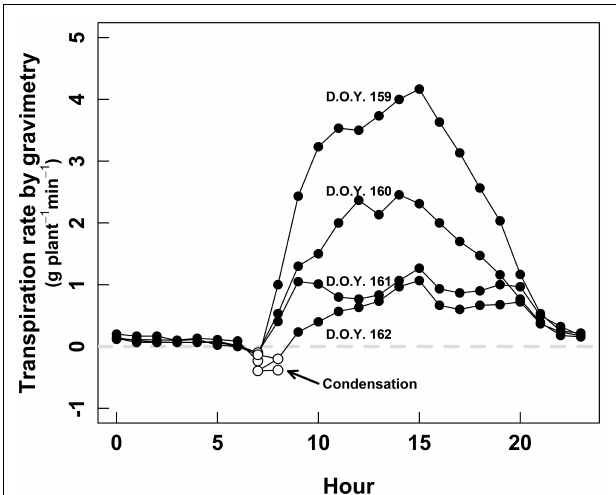
FIGURE 4 | Daily course of the whole-plant transpiration measured by gravimetry during the second calibration session (D.O.Y. 158 to D.O.Y. 162). The black dots denote positive transpiration, while the white dots denote negative transpiration, interpreted as condensation during the earlier hours of the